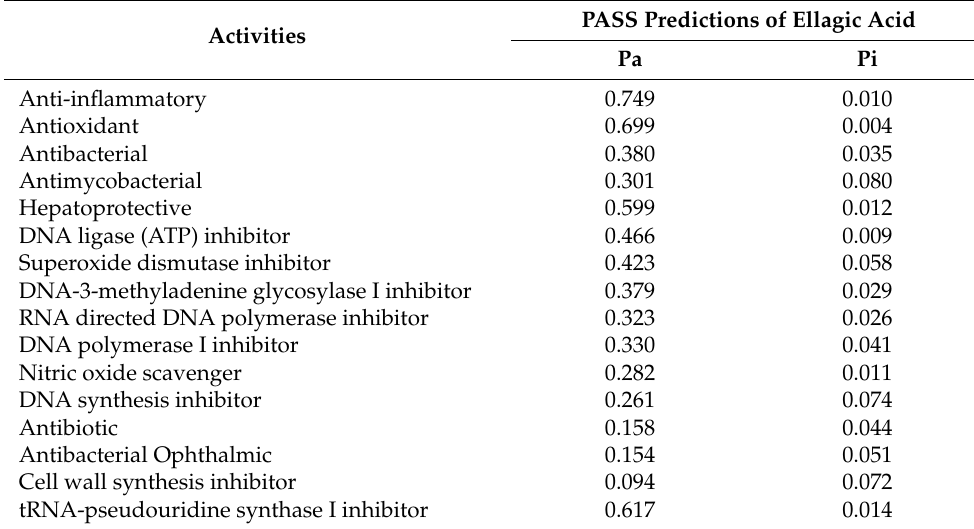
Table 3. In silico analysis of the biological activities of Ellagic Acid (ElAc).